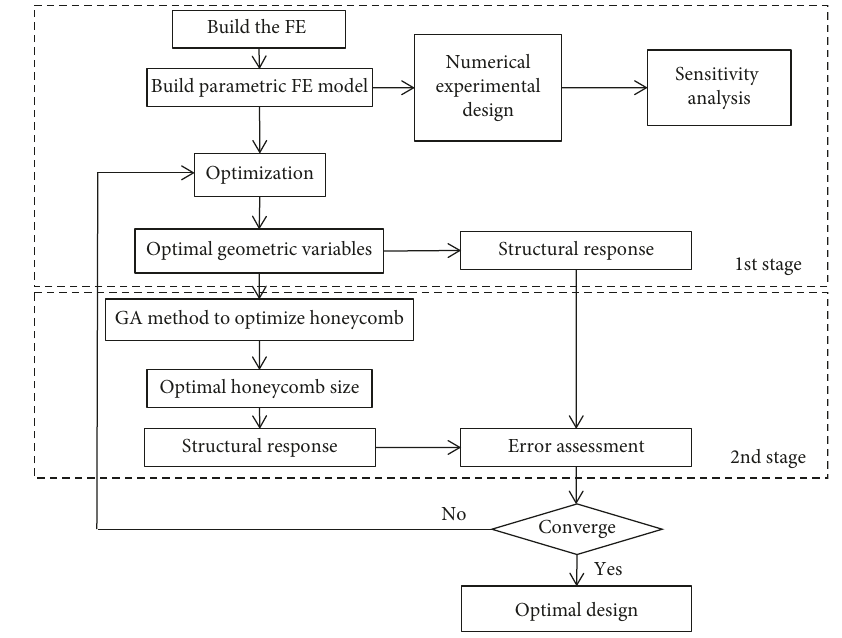
Figure 4: Design optimization framework.